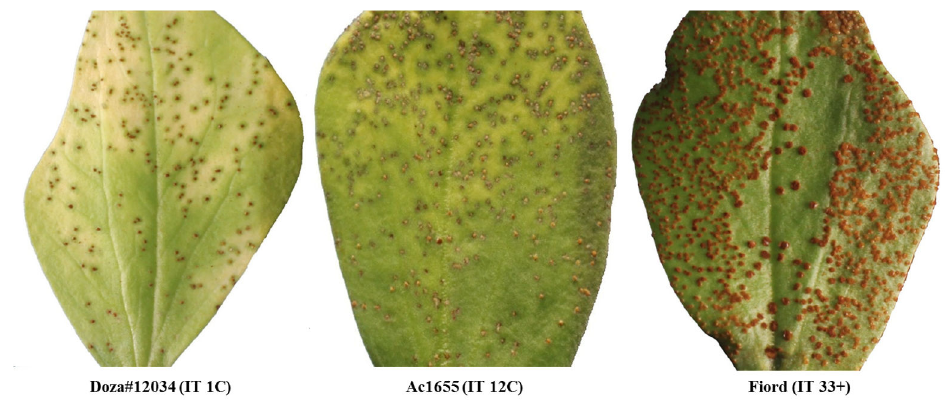
Figure 1. Infection types produced by parental genotypes when inoculated with the U. viciae-fabae pathotype